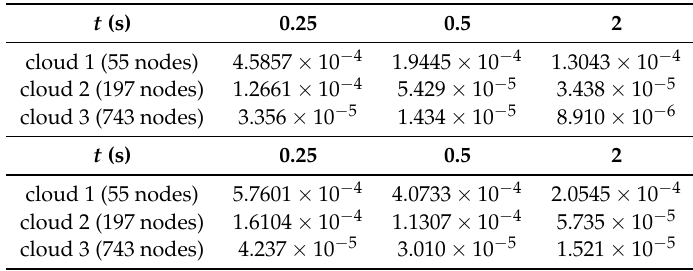
Table 1. l 2 and l ∞ norms of the errors of the real parts, respectively.